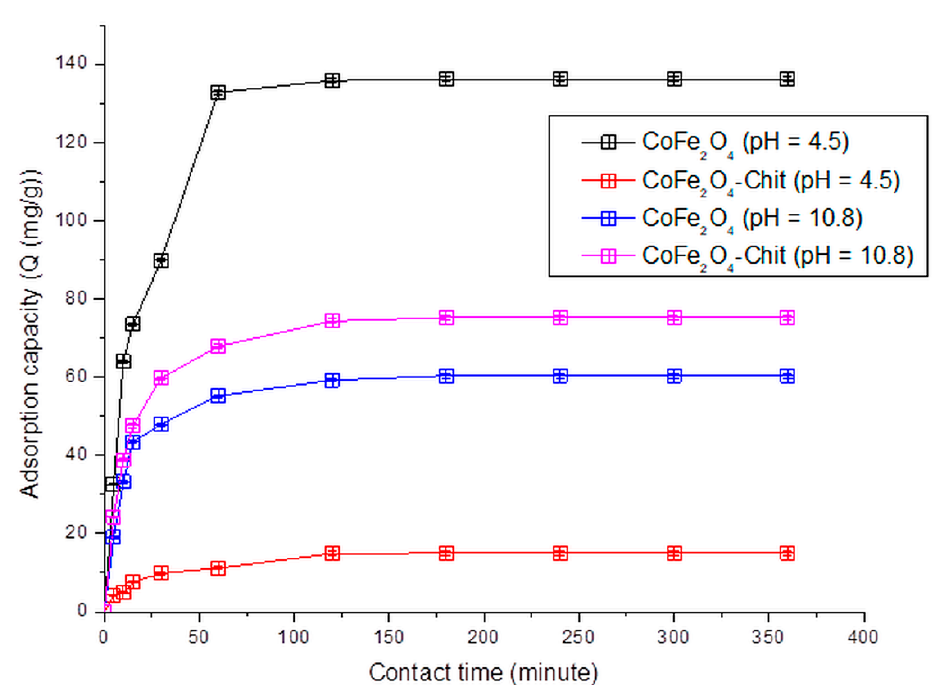
Figure 12. The variation of CoFe 2 O 4 /CoFe 2 O 4 –Chit adsorption capacity versus contact time at pH = 4.5 and pH = 10.8 for the CR adsorption process.